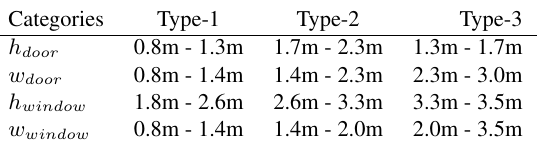
Table 1: Variations of window and door heights and widths of our experiments. These define a compact support S over θ .